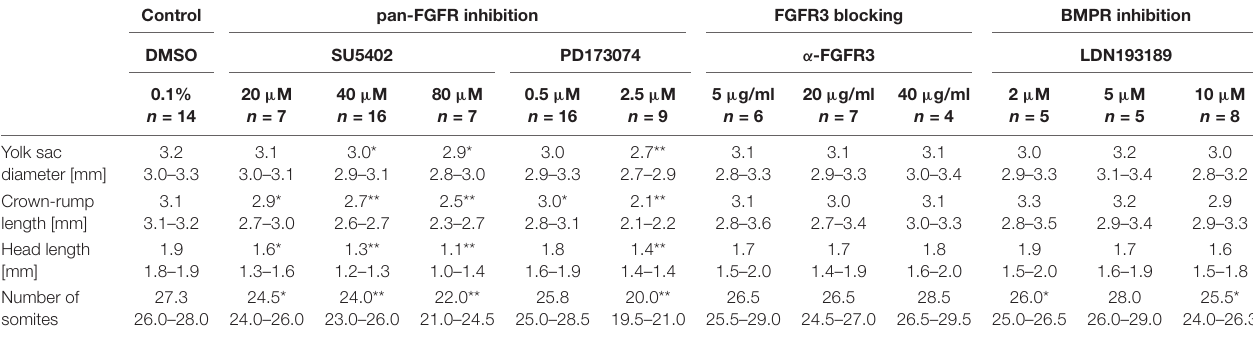
TABLE 1 | Developmental characteristics of 9–14 somite mouse embryos cultured for 24 h.